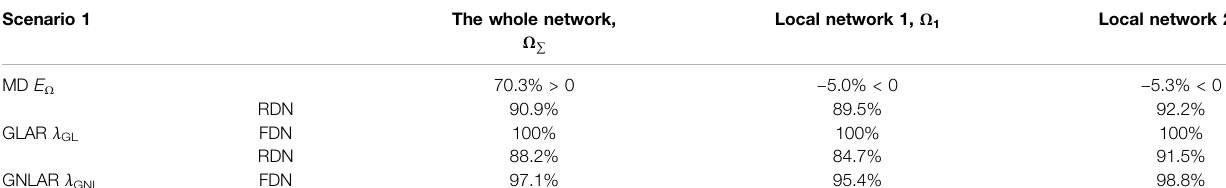
TABLE 2 | Matching degree and daily accommodation ratio of scenario 1. Scenario 1